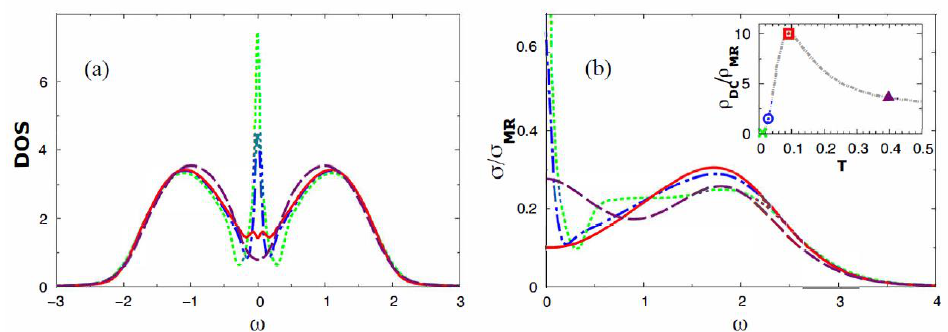
Figure 9. ( a ) DMFT results for the evolution of the single-particle Density of States (DOS) for several values of the temperature (reprinted with permission from Ref. [66] Copyright 2010 American Physical Society), as well as ( b ) that of the optical conductivity, in the strongly correlated metallic regime. Different colors correspond to the four distinctive transport regimes (inset in ( b )). DOS fea- tures a distinct quasiparticle peak at low temperatures, which is thermally destroyed at temperature T max = T BR ∼ ( m ∗ ) − 1 , where the resistivity (inset of right panel) reaches a maximum. The optical conductivity displays the corresponding suppression of the low-frequency Drude peak around the same